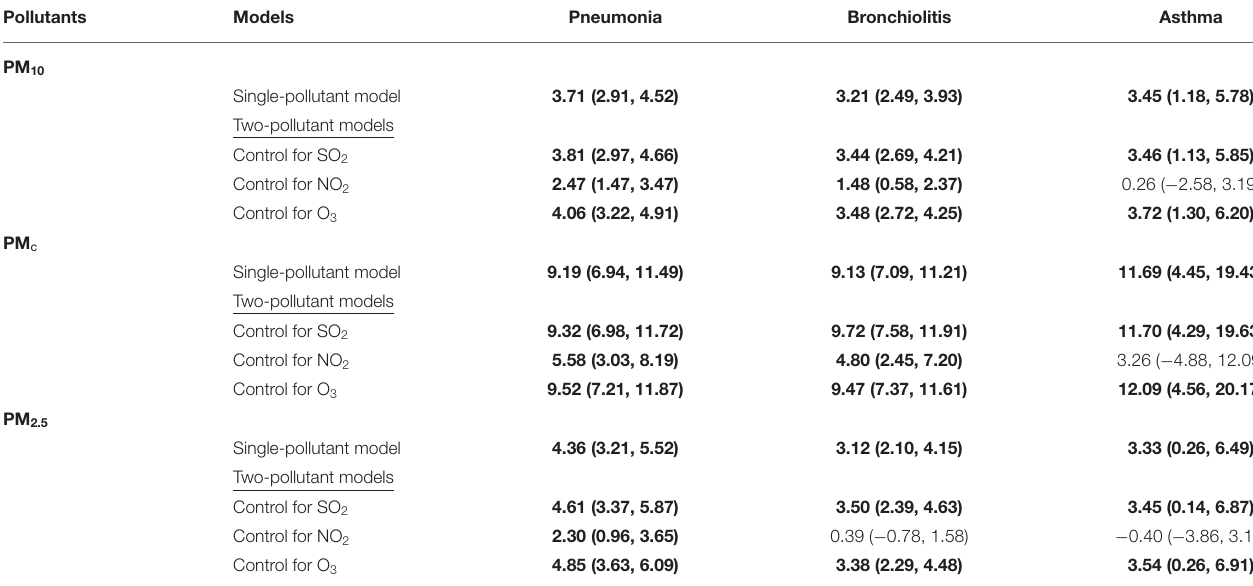
TABLE 2 | Excess risk and 95% CIs of pneumonia, bronchiolitis, and asthma for each 10 µ g/m 3 increase in PM 2.5 , PM c , and PM 10 using single- and two-pollutants models at lag03. Pollutants